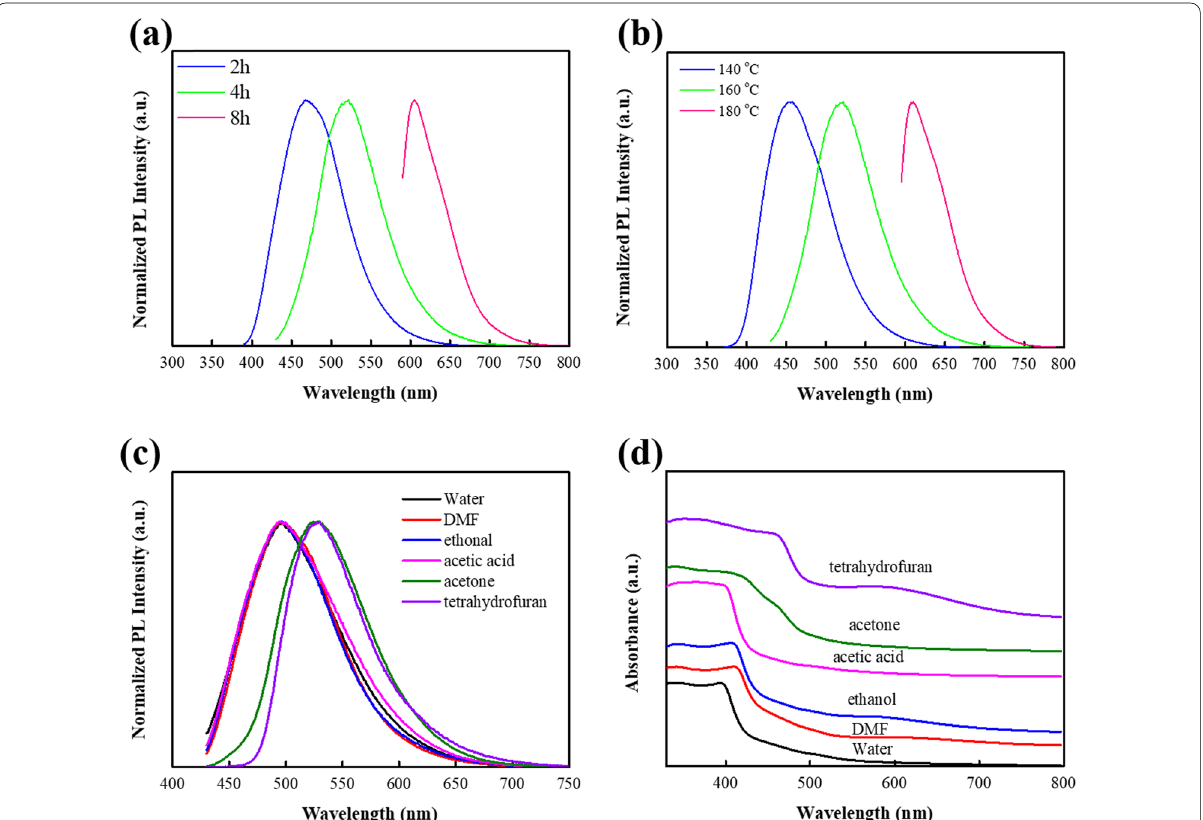
Fig. 6 Normalized PL emission spectra of g-CDs with a different heating times, b different heating temperature. c Normalized PL spectra ( λ ex 420 nm) and d UV–vis absorption spectra of g-CDs dispersed in six =